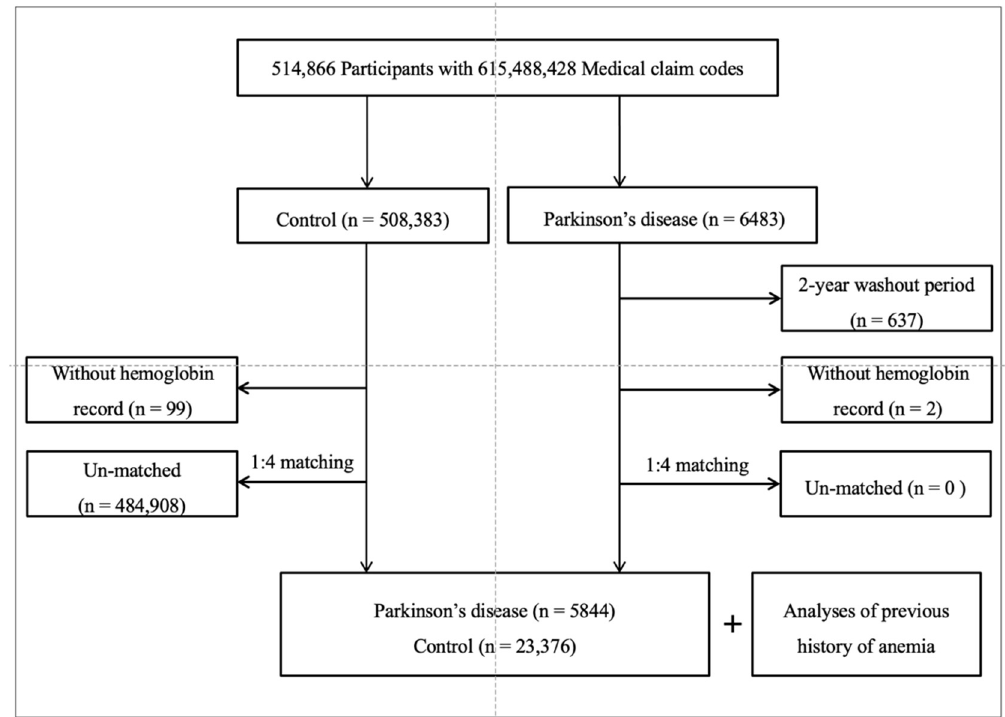
Figure 1. A schematic illustration of the participant selection courses used in this study. Of the total 514,866 participants, 5844 Parkinson’s disease patients were matched with 23,376 control participants for age, sex, income, and region of residence.